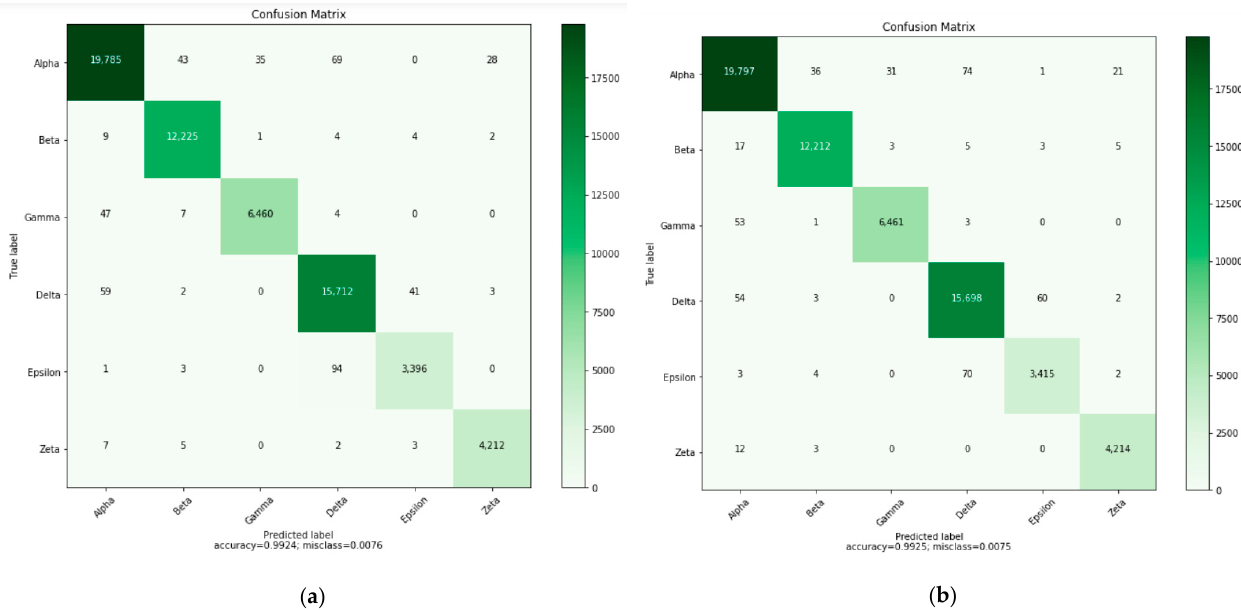
Figure 10. Confusion matrix of the proposed two-channel CNN–BiLSTM model: ( a ) run on the CPU and ( b ) run on the GPU.